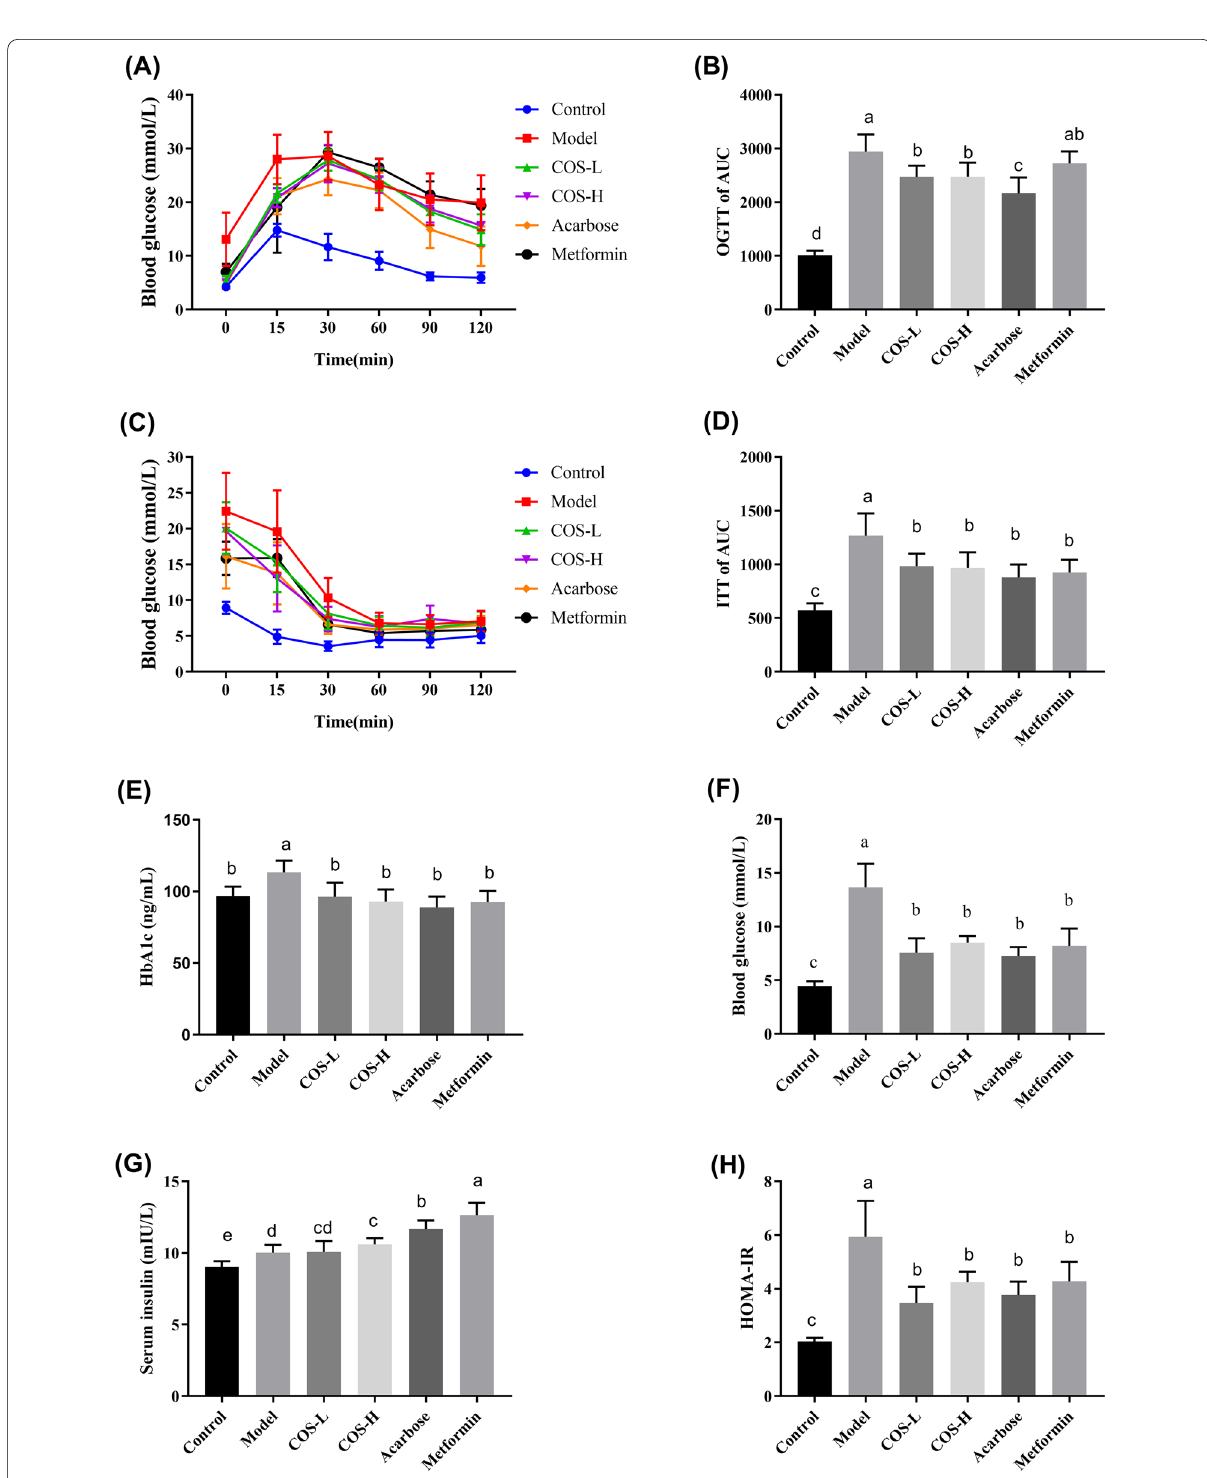
Fig. 4 The impact of COS on the insulin and glucose tolerance of the mice. A OGTT, B glucose AUC, C ITT, D insulin AUC, E HbA1c levels, F blood glucose level, G levels of serum insulin, H HOMA-IR